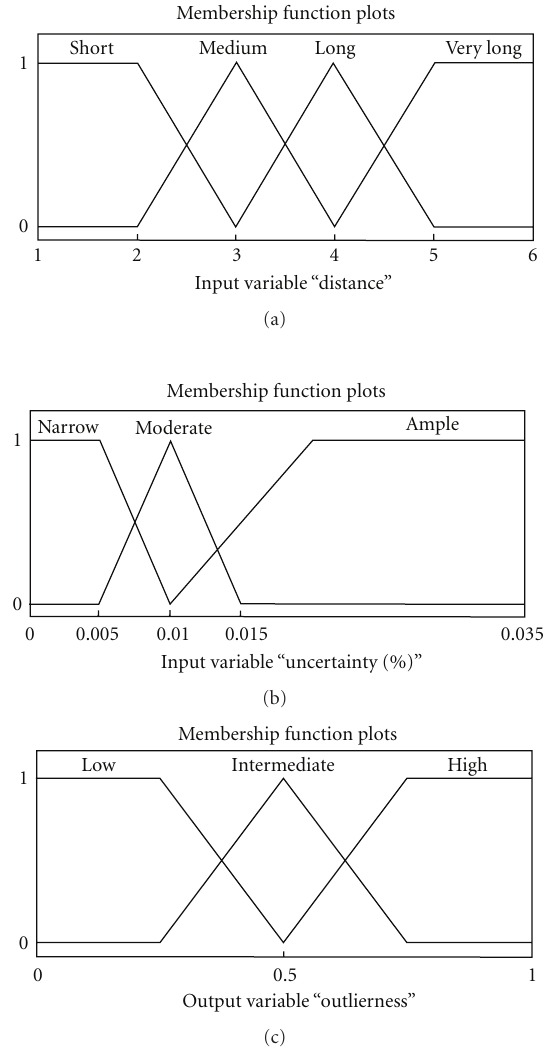
Figure 1: Membership functions: (a) distance; (b) %uncertainty; (c) outlierness.